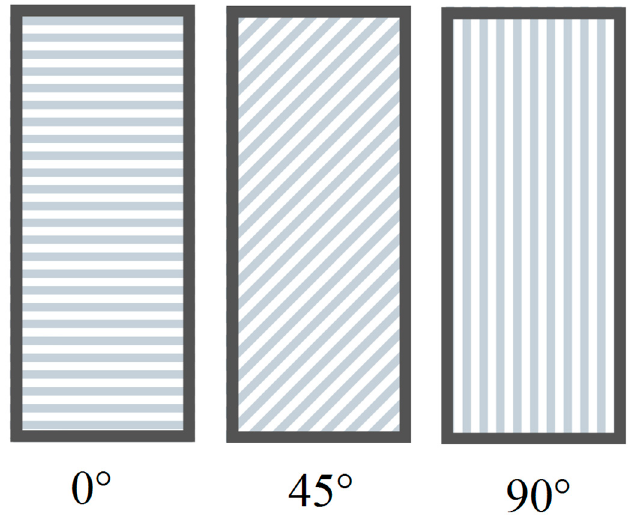
Figure 1. Scheme of the fabricated layers in the SLM samples according to the different building orientations—0°, 45° or 90°.